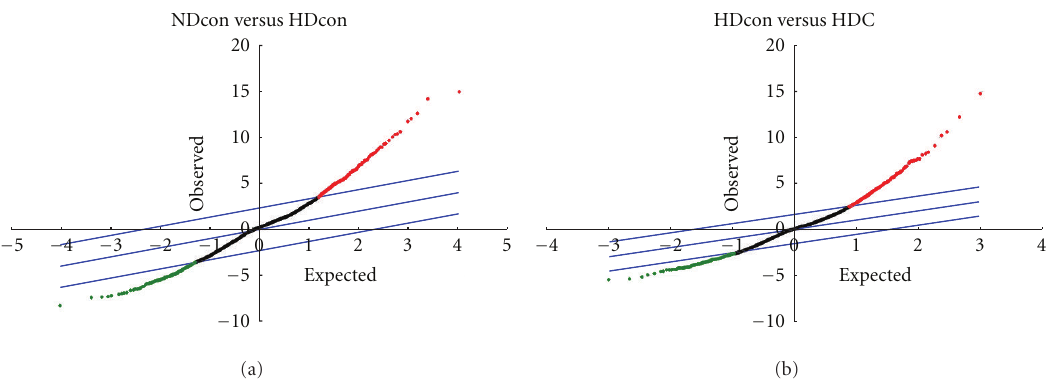
Figure 3: SAM scatter plot of observed relative di ff erence versus the expected relative di ff erence. The genes showing significant di ff erence in expression between the NDcon and the HDcon or the HDcon and the HDC mice were identified. Broken lines represent δ = 0.66.